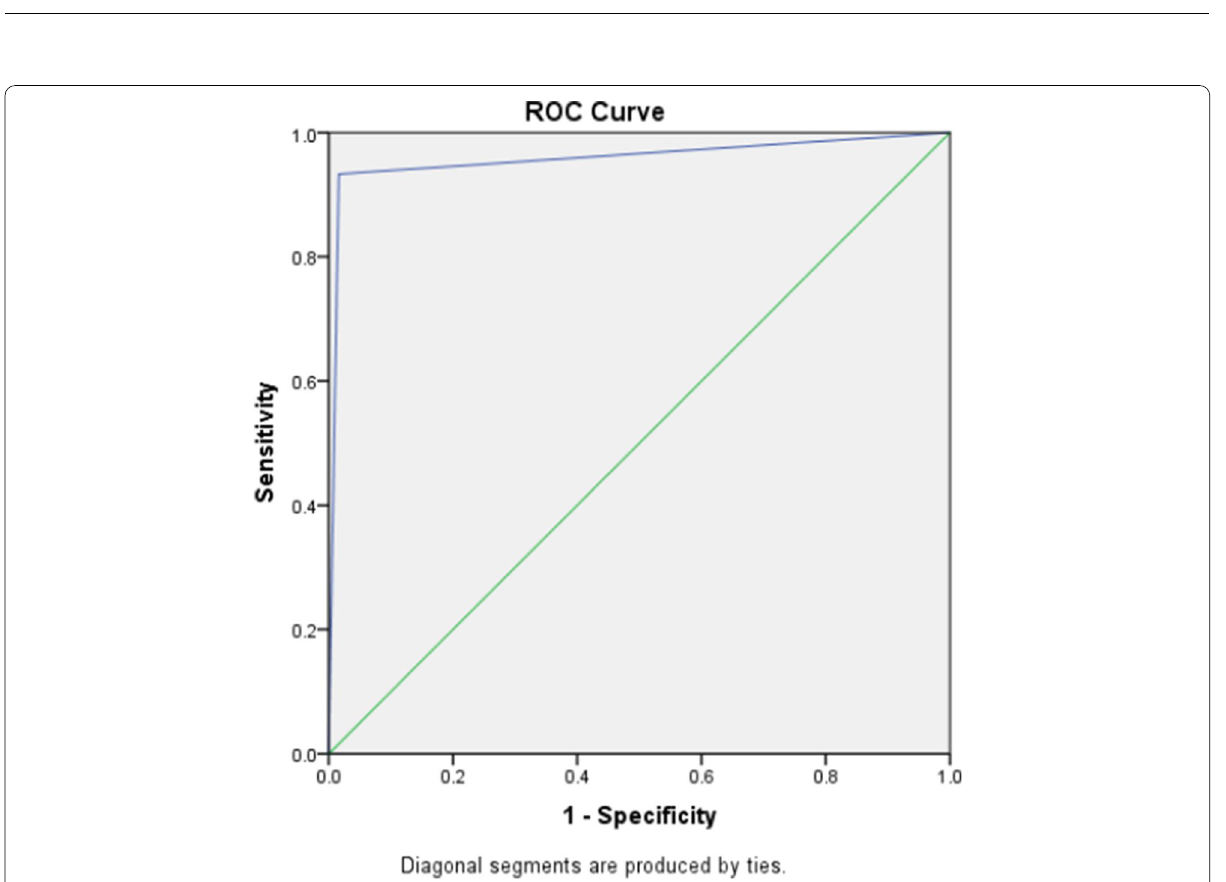
Fig. 2 ROC curve analysis for HbA2